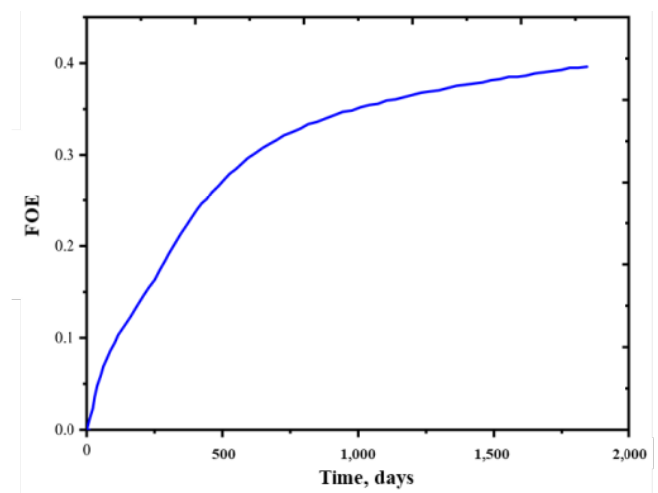
Figure 20. Field oil production total for vertical well.